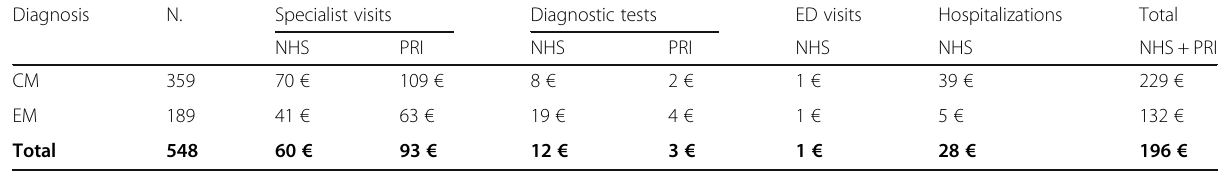
Table 4 Annual cost of specialist visits, diagnostic tests, hospitalizations and ED visits by gender, age and migraine status Diagnosis